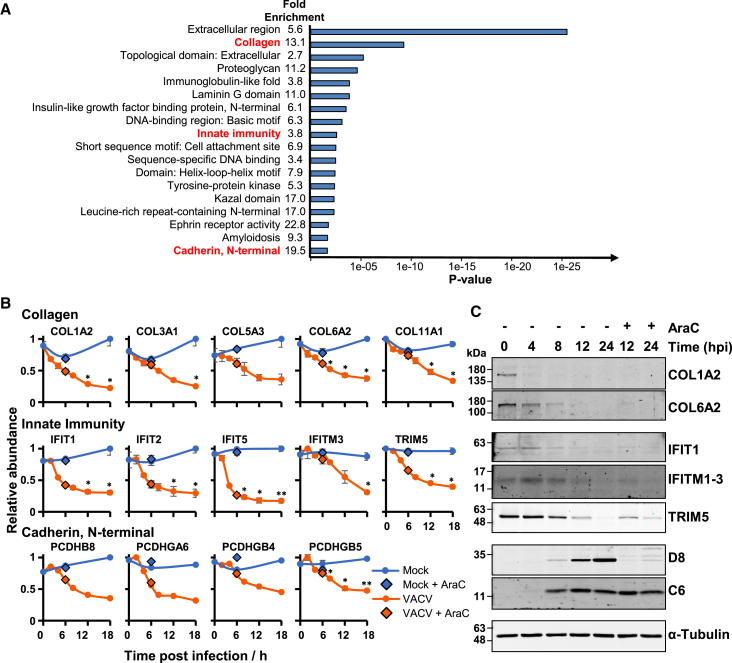
Downregulation of Multiple Collagens, Protocadherins, and Innate Immune Mediators(A) Functional enrichment within all proteins that were downregulated >2-fold at any point during infection compared to 18-h mock samples. A background of all quantified human proteins was used. Shown are representative terms from each cluster with Benjamini-Hochberg-corrected p values of < 0.05. Components of each significantly enriched cluster are shown in Table S2E. A similar analysis was performed for proteins upregulated >2-fold; however, this did not reveal any significantly enriched clusters.(B) Example temporal profiles of collagens, innate immune mediators, and protocadherins. Data are represented as mean ± SEM (n = 3); ∗p < 0.05 and ∗∗p < 0.01 (see STAR Methods). Error bars and statistics are not included on the plots for PCDHGA6, PCDHGB4, and PCDHB8, as these proteins were not quantified in all three replicates; full data are shown in Table S1.(C) Validation of temporal profiles shown in (B) by immunoblot of HFFFs infected with VACV (MOI = 5). Viral proteins D8 and C6 were representative of late and early gene expression, respectively.